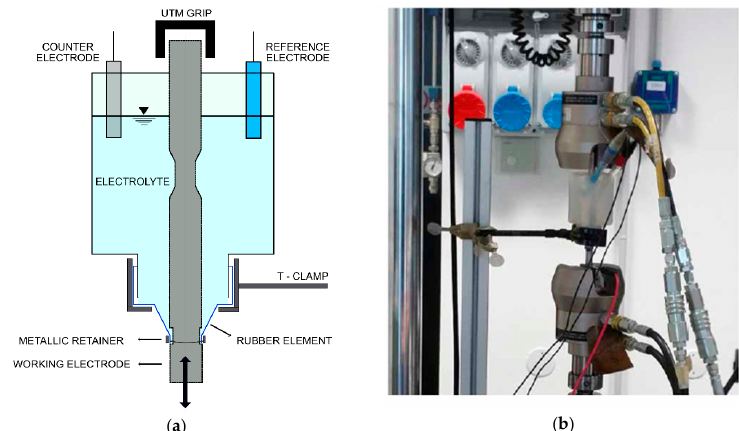
Figure 2. ( a ) Electrochemical cell design; ( b ) photograph of the experimental setup. Table 2. Testing parameters of fatigue